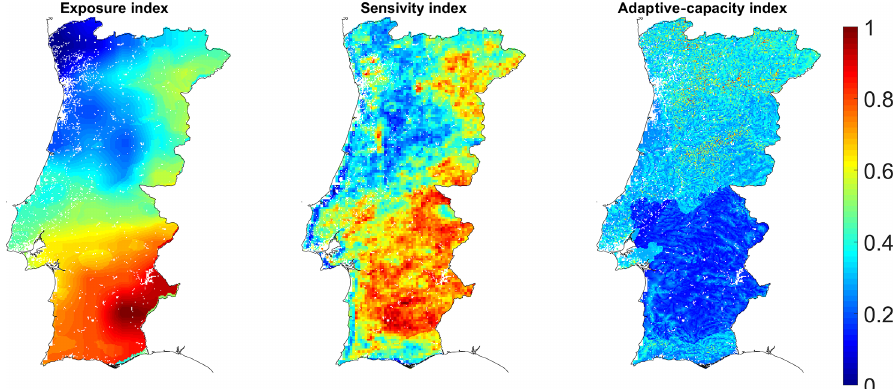
Figure 9. Exposure, sensitivity and adaptive-capacity indices obtained with variance method.